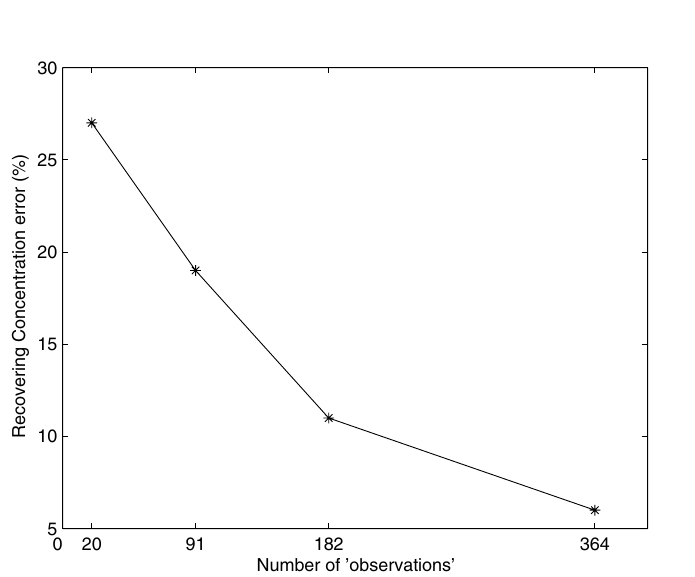
Table 3. Recovering concentration’s error for different number of observations ( t 1 = 45 days, t f = 25 days and l 1 = 5 days).